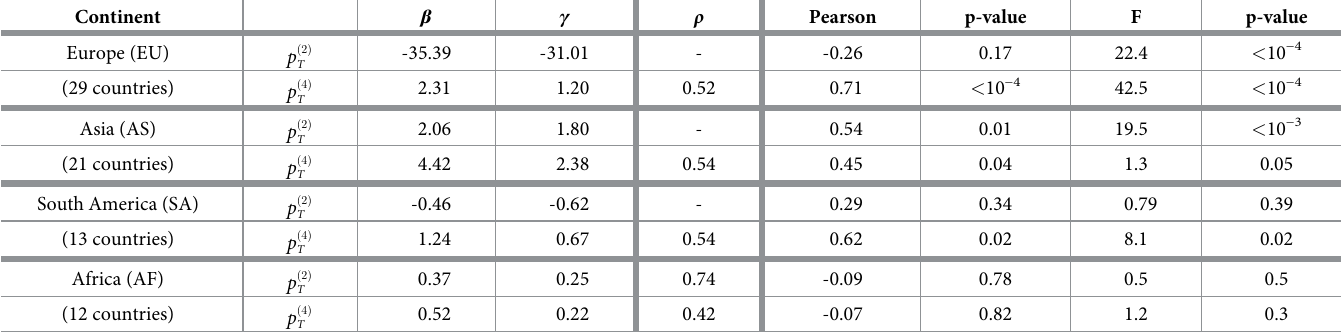
Table 3. Main results for the different countries aggregation. Continent